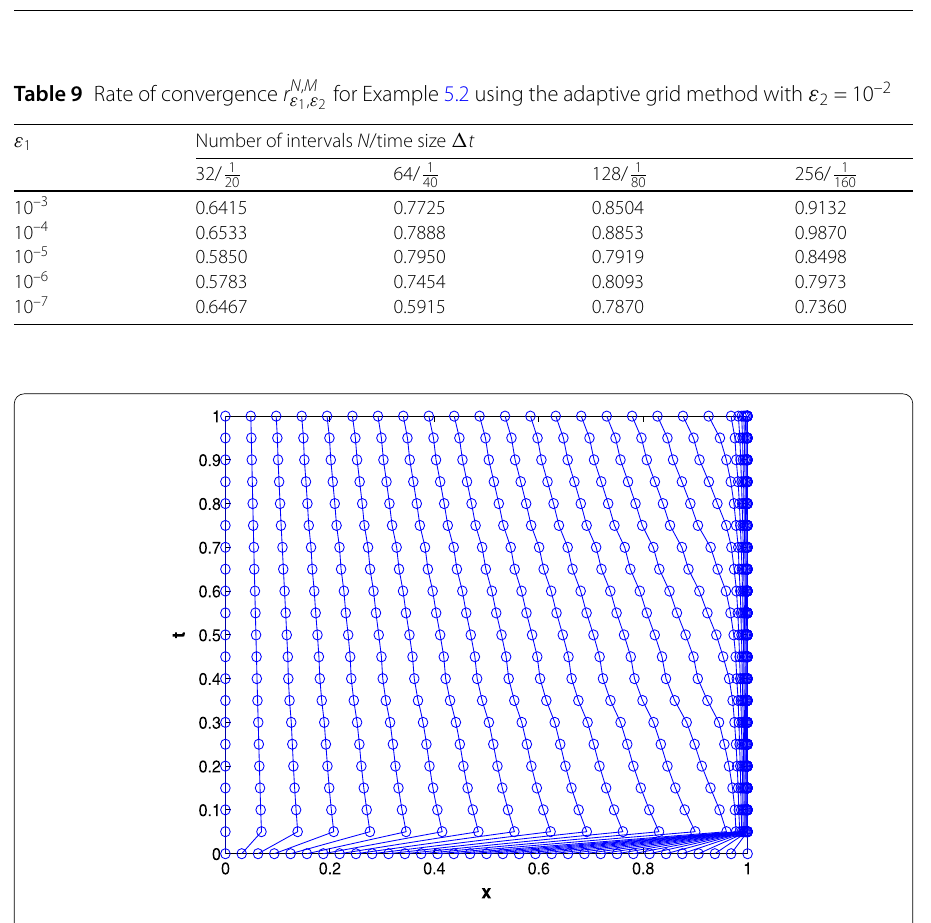
Fig. 5. In Figs. 6–7, the numerical solution and exact solution of Example 5.2 for N = M = 64, ε 1 = 10 –2 , and ε 2 = 10 –4 are plotted, respectively. Moreover, the maximum